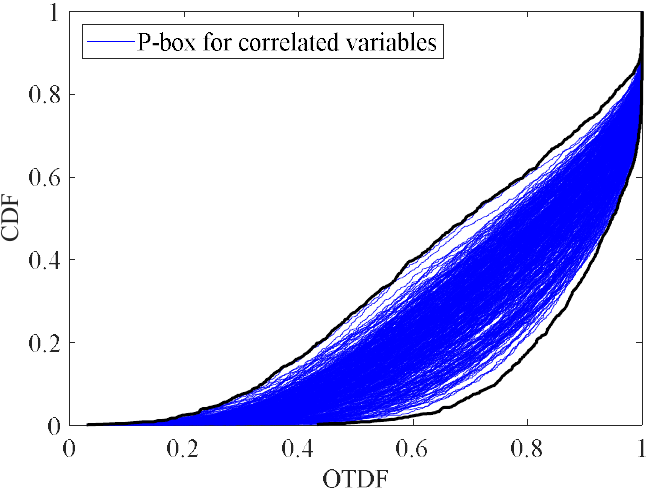
Figure 14. The initial p−box for OTDF with correlated variables.